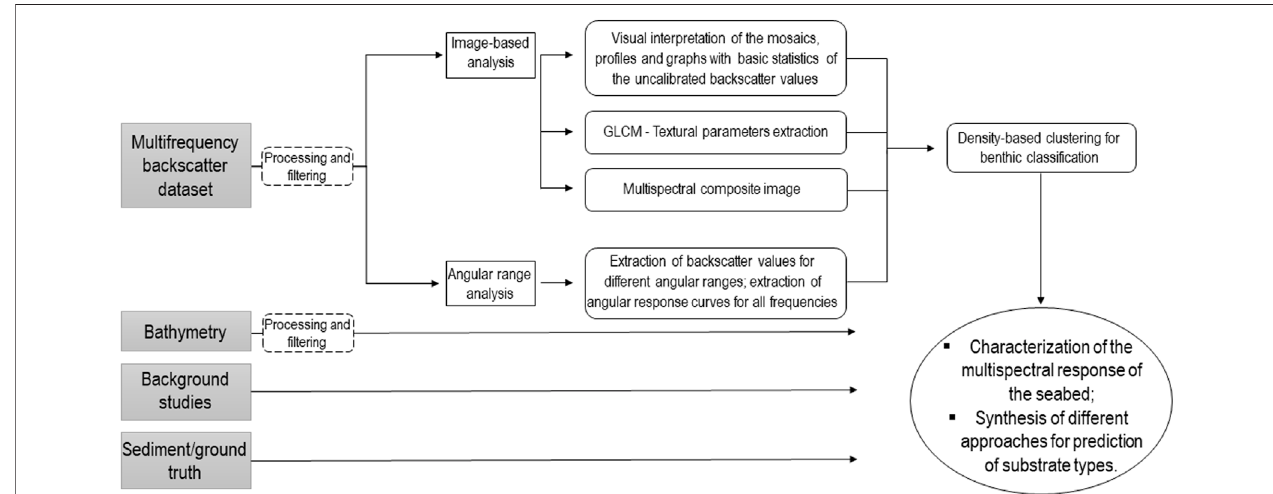
FIGURE 2 | Flow indicating the steps of the methodological